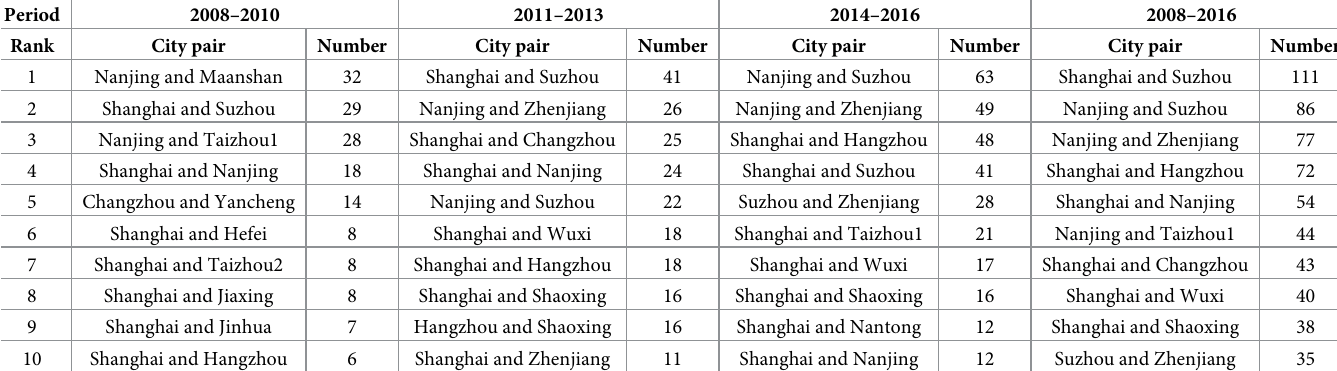
Table 11. Top 10 cities, cross-city cooperation, based on common patent data of the Yangtze River Delta Urban agglomeration, 2008–2016. Period